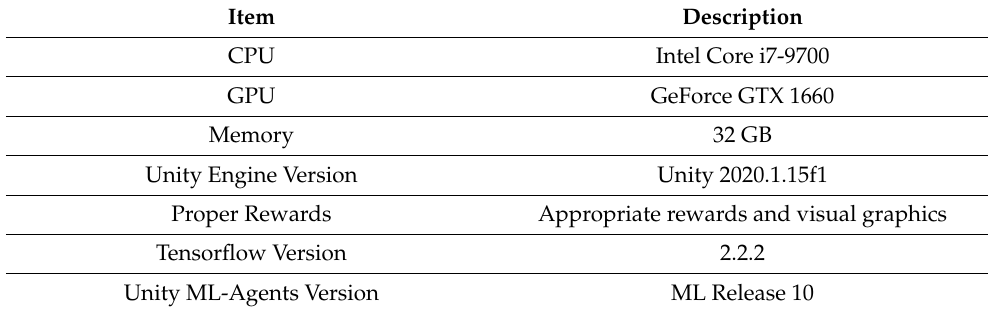
Table 3. Experiment environment.